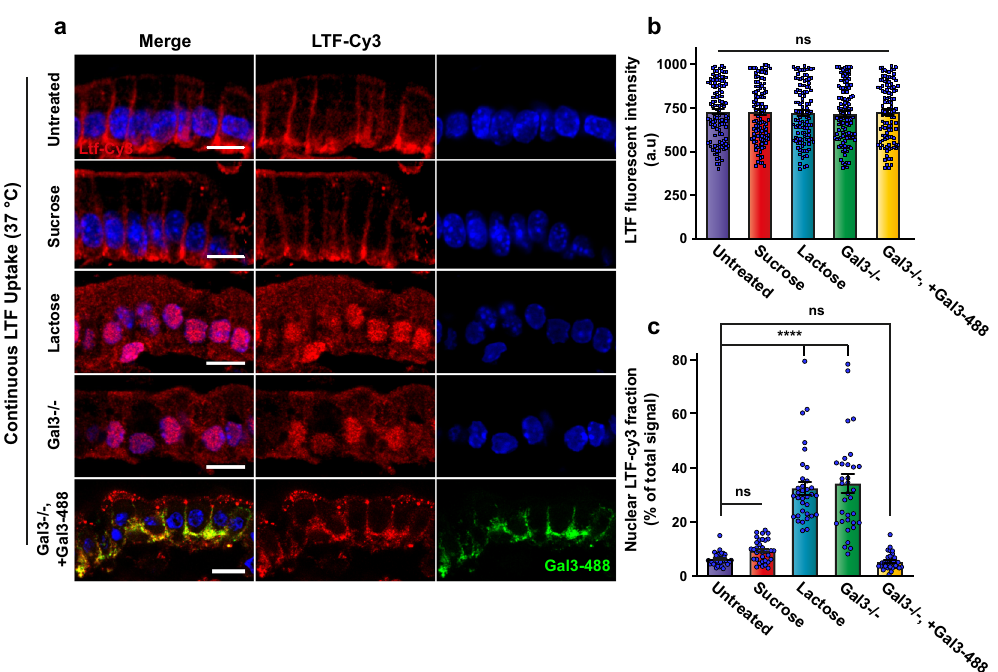
Fig. 7 LTF transcytosis is Gal3-dependent. a For all experiments that are shown in this fi gure, LTF – Cy3 (red) at 20 µ g/mL was incubated for 30 min at 37